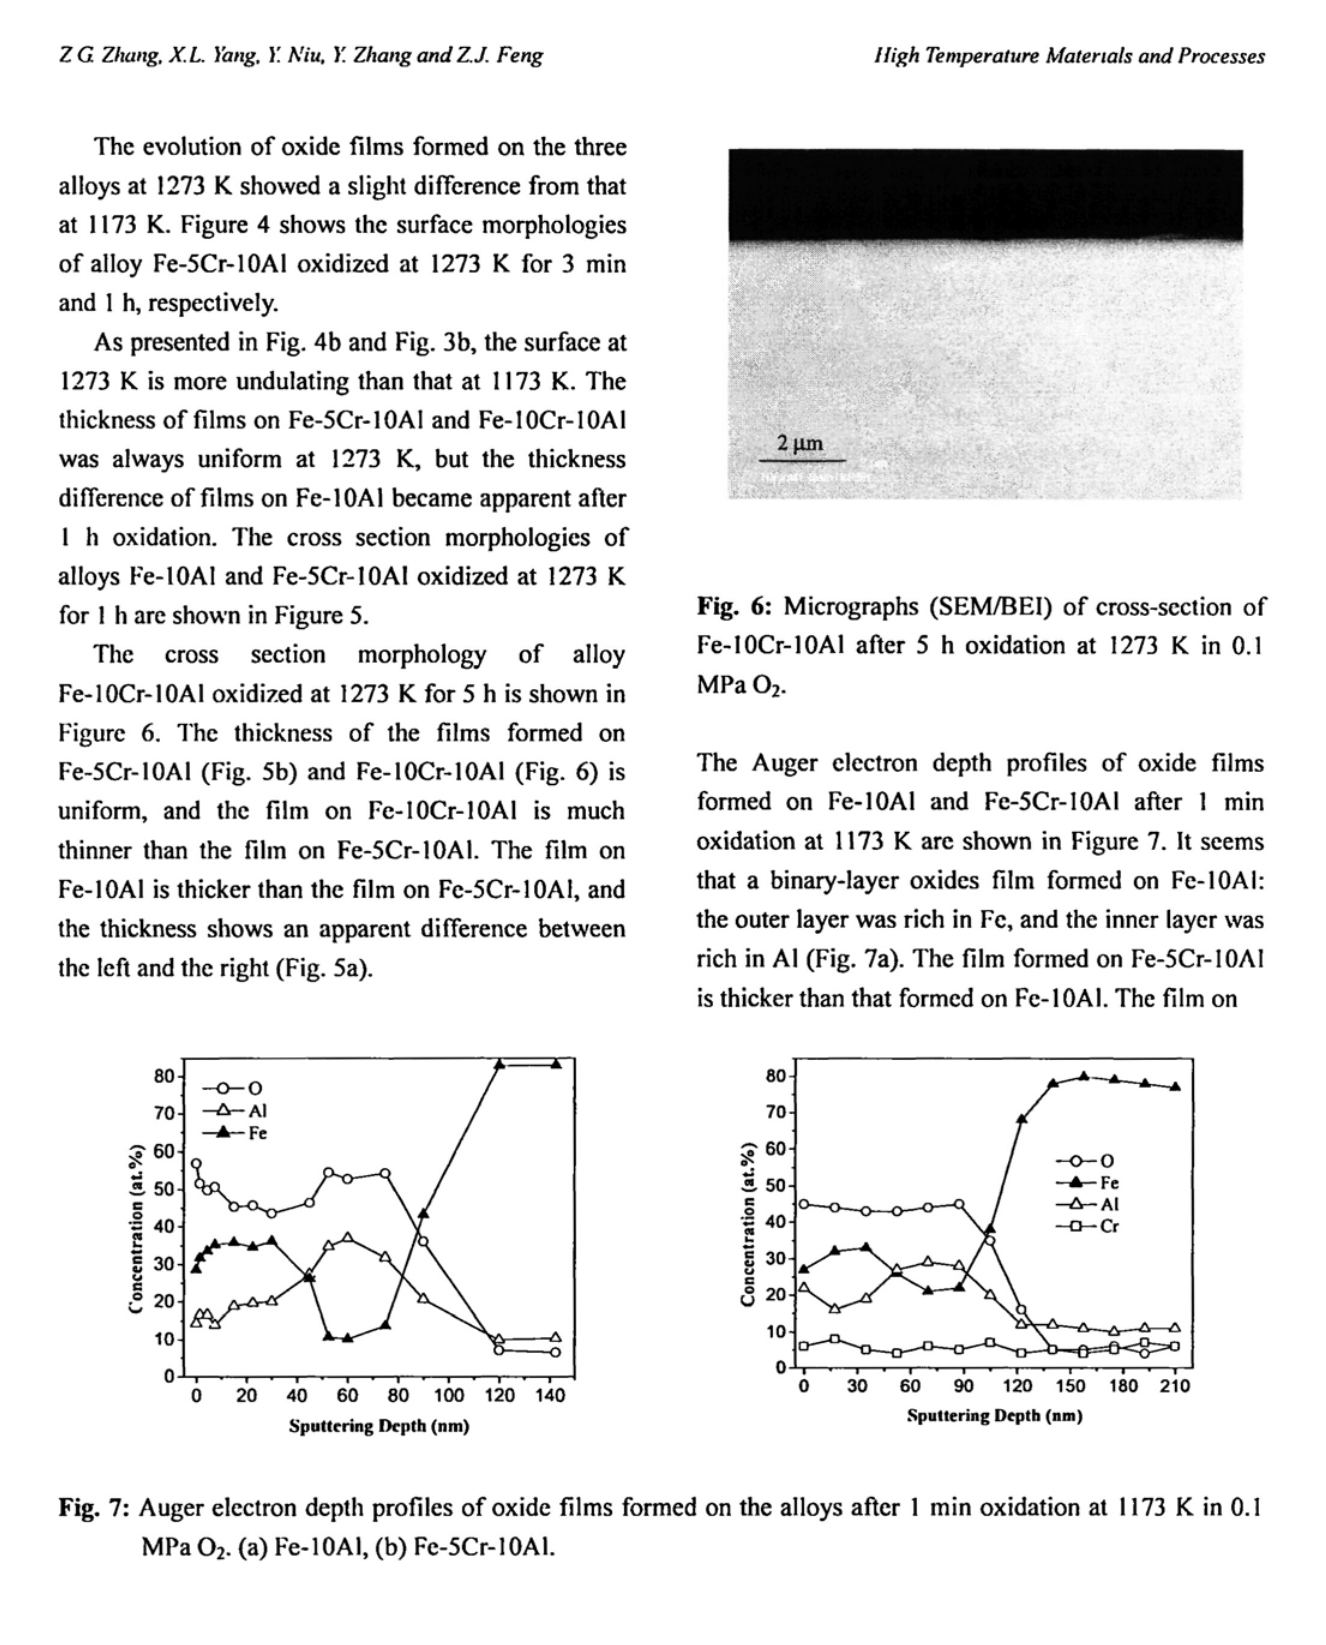
Fig. 7: Auger electron depth profiles of oxide films formed on the alloys after l min oxidation at 1173 K in